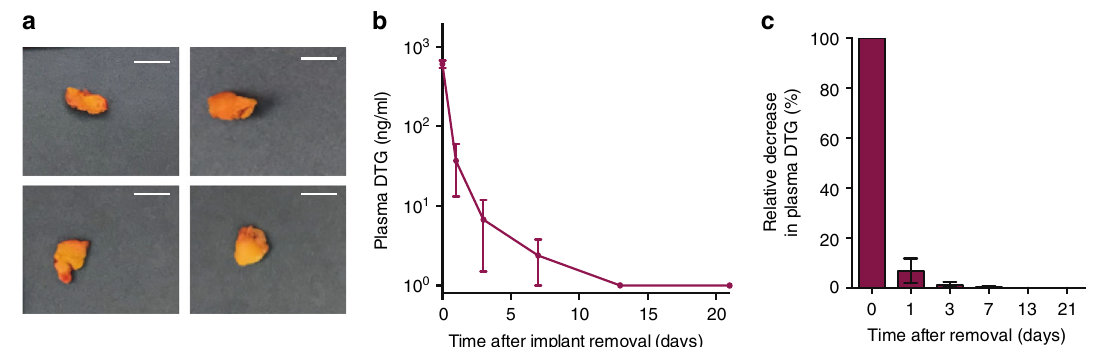
Fig. 9 Removal of DTG-ISFI results in rapid reduction of plasma drug levels. Mice were administered DTG-ISFI subcutaneously (250 mg/kg, n = 5). Four months later, implants were removed and levels of DTG in plasma were monitored for 3 weeks. a Implants removed from mice 4 months post injection; bar indicates 5 mm. b plasma concentration of DTG after implant removal ( n = 5, mean ± s.e.m.). c percent decrease in plasma DTG concentration relative to day 0 ( n = 5, mean ± s.e.m.). Source data are provided as a Source Data fi